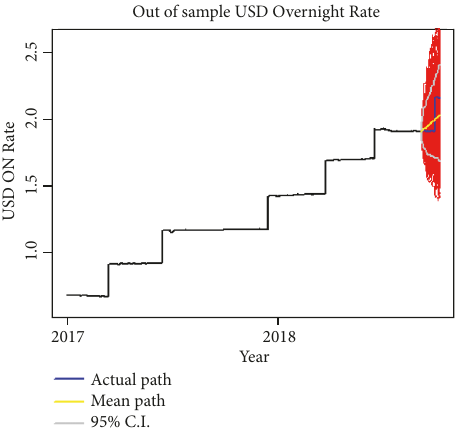
Figure 3: Visual Plot of the Simulated USD ON LIBOR.